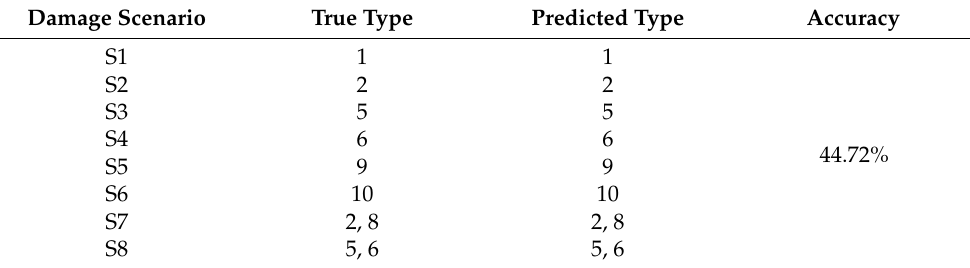
Table 8. Accuracy of different damage scenarios by SVM.